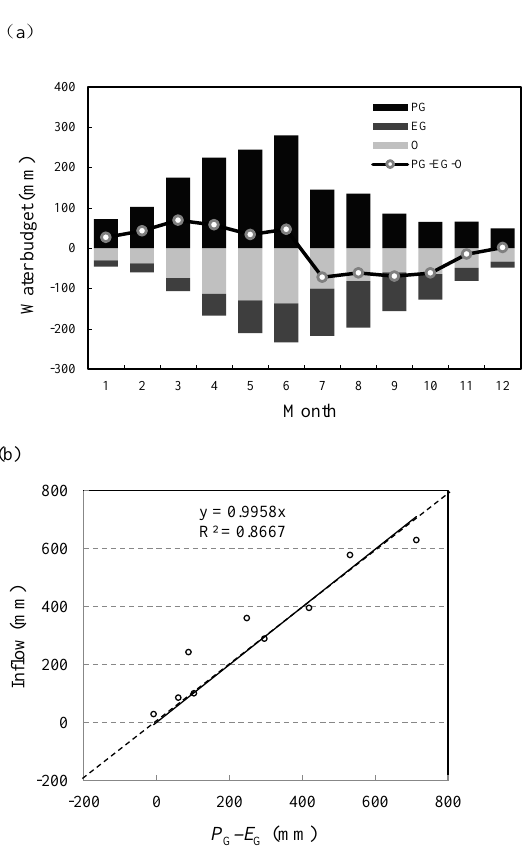
Figure 5. (a) Multi-year mean of monthly precipitation ( P G ) and evapotranspiration ( E G ) for the Poyang Lake basin, and outflow ( O ) into the Yangtze River. (b) The relationship between P G − E G and inflow for nine cases of Poyang Lake droughts. All the wa- ter amounts are normalized to equivalent water height of the whole Poyang Lake